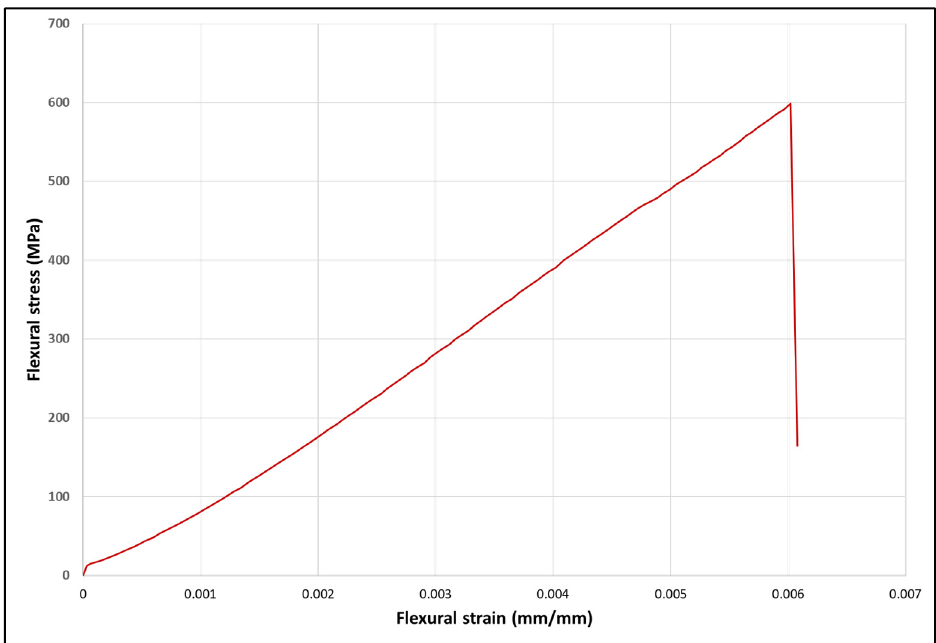
Figure 2. Typical Stress/Strain plot for a specimen.